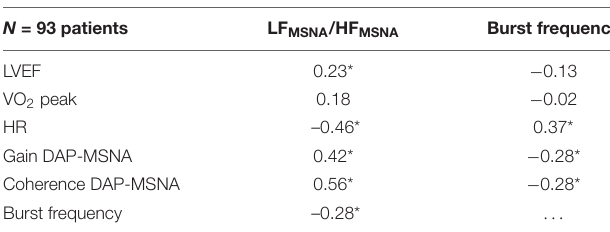
TABLE 3 | Relationship between oscillatory pattern of MSNA and burst frequency with functional and hemodynamic characteristics and sympathetic baroreflex function in HFrEF